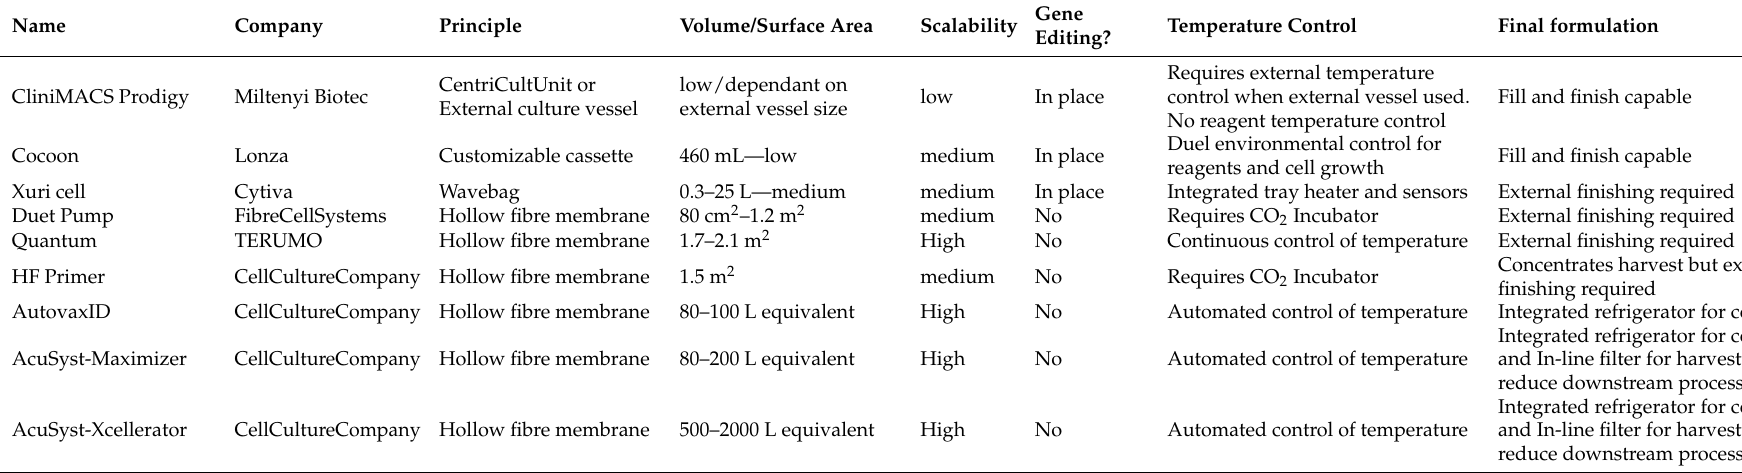
Table 1. Comparison of platforms developed for the manufacturing CAR-T cell